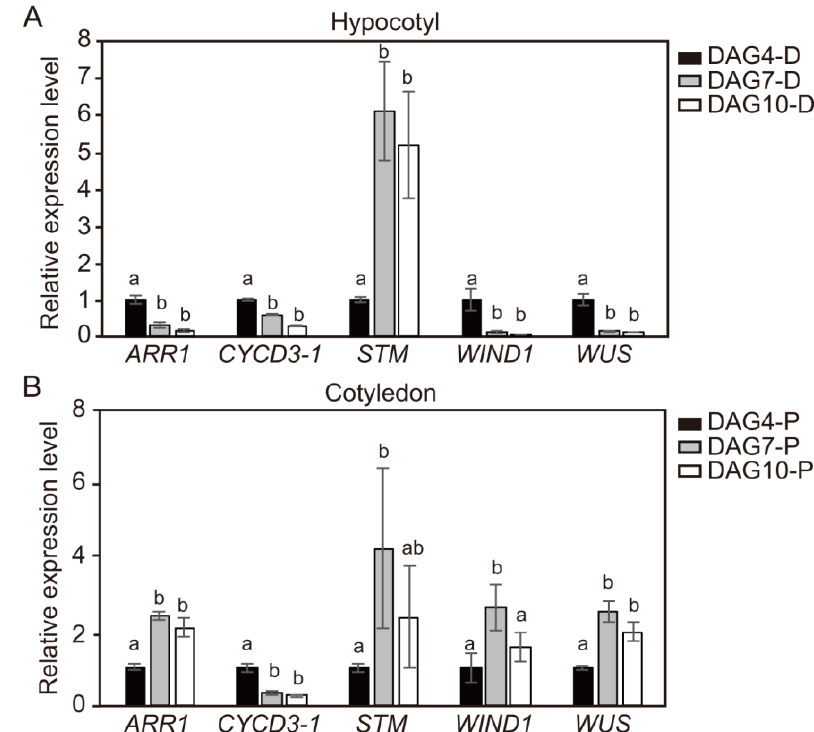
Figure 4. The relative expression levels of CYCD3-1 and shoot regeneration regulatory genes according to the age of hypocotyl and cotyledon explants seedlings. ( A ) Normalized relative expression of ARR1 , CYCD3-1, STM , WIND1 , and WUS at the distal position of hypocotyls of DAG4, DAG7, and DAG10 seedlings determined using quantitative reverse transcription PCR (qRT-PCR). ( B ) The relative gene expression level of ARR1, CYCD3-1 , STM , WIND1 , and WUS at the proximal position of cotyledon explants of DAG4, DAG7, and DAG10 seedlings. Data are representative of the results from three independent experiments. Error bars represent SD ( n = 3). Di ff erent letters in each gene indicate statistically significant di ff erences the three DAG groups (AVOVA followed by a Turkey’s test, p < 0.05). DAG = day after germination; D = distal; P =